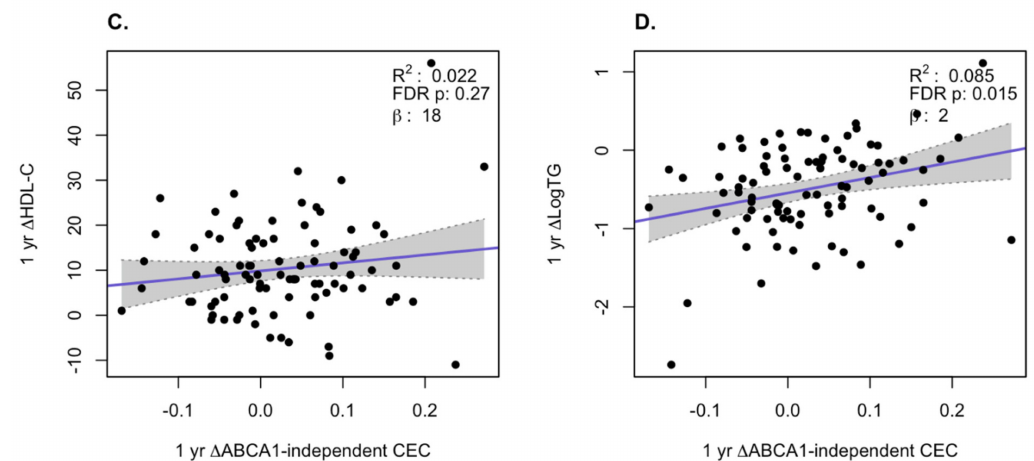
Figure 3. Correlation of changes of ABCA1-independent CEC with changes in clinical variables at 1 year. Changes in BMI ( A ), HbA1c ( B ), HDL-C ( C ), and log TG ( D ). The gray region is the 95% confidence interval.